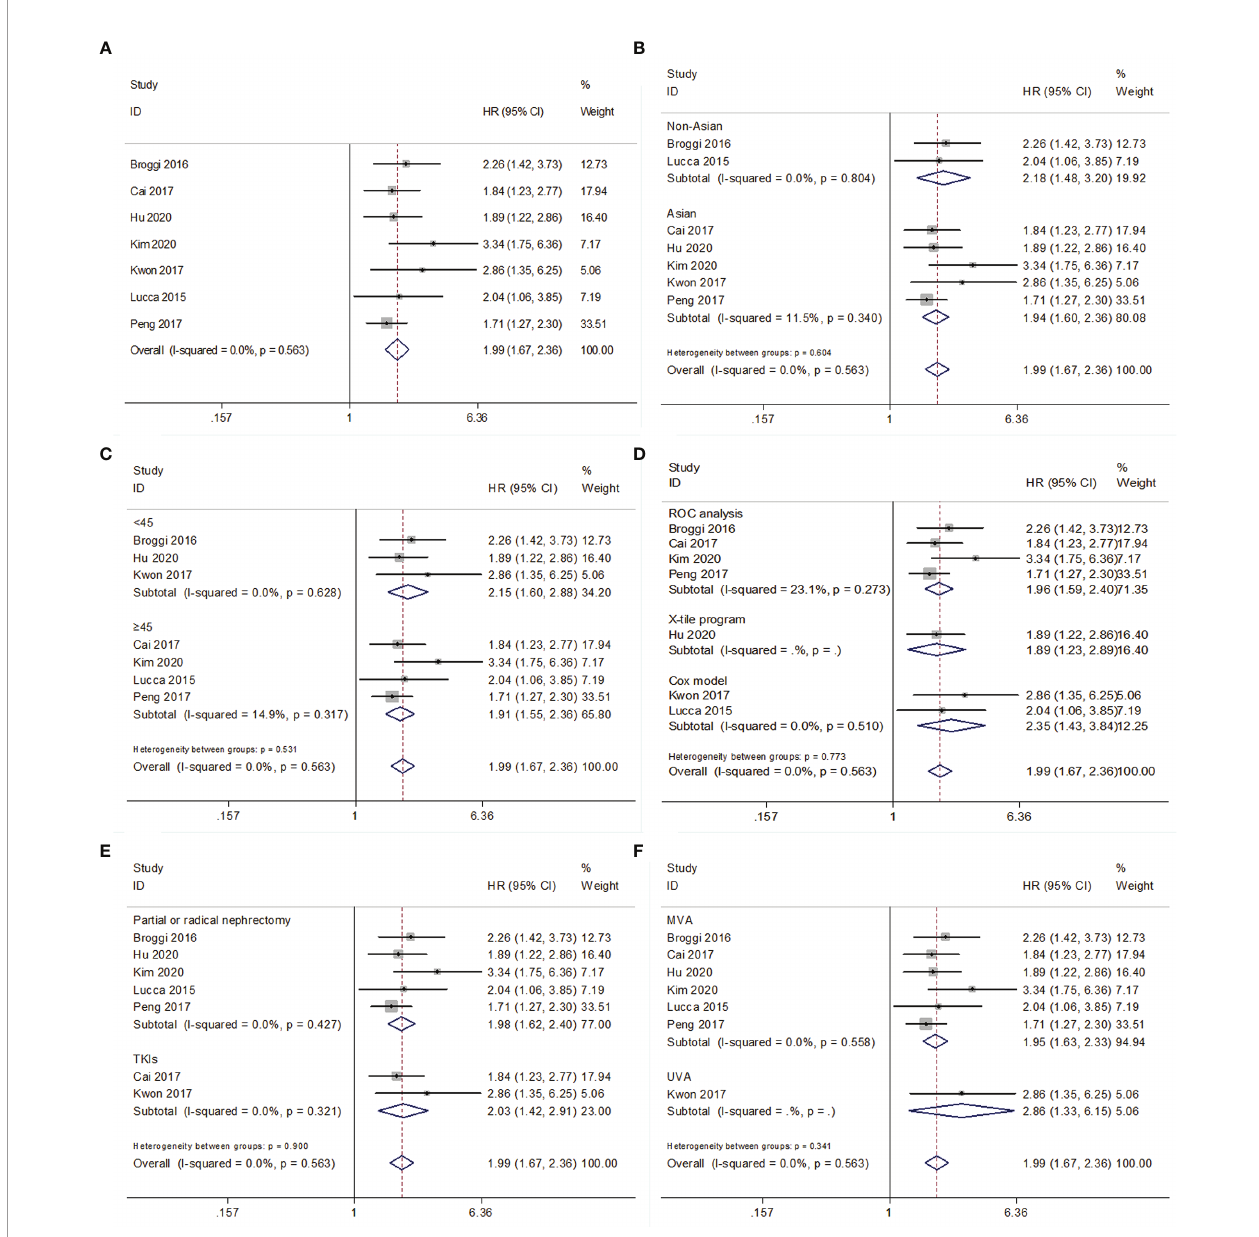
FIGURE 3 | Forest plot examining the association between PNI and PFS/DFS/RFS in patients with RCC. (A) overall patient population; (B) subgroup analysis by various ethnicities; (C) subgroup analysis by various cut-off values of PNI; (D) subgroup analysis by various cut-off value determination methods; (E) subgroup analysis by various treatment methods; (F) subgroup analysis by various survival